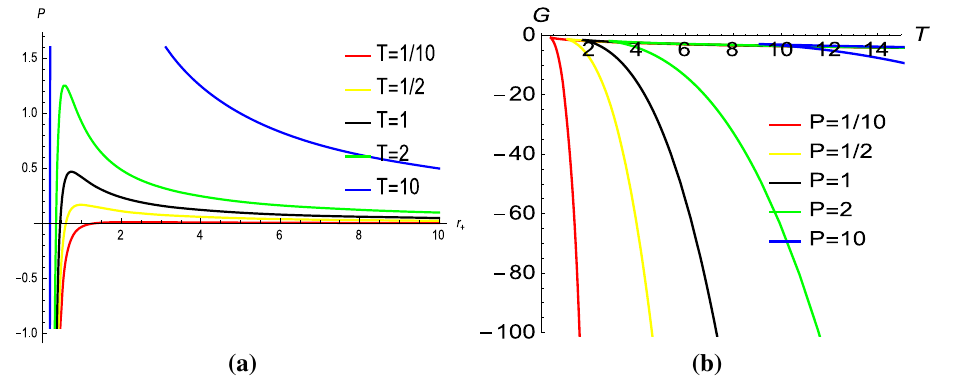
Fig. 2 a The thermodynamic pressure for η = − 1, q = 1 with various choices of T . b The Gibbs free energy of phantom AdS black holes for η = − 1, q = 1 with various choices of P